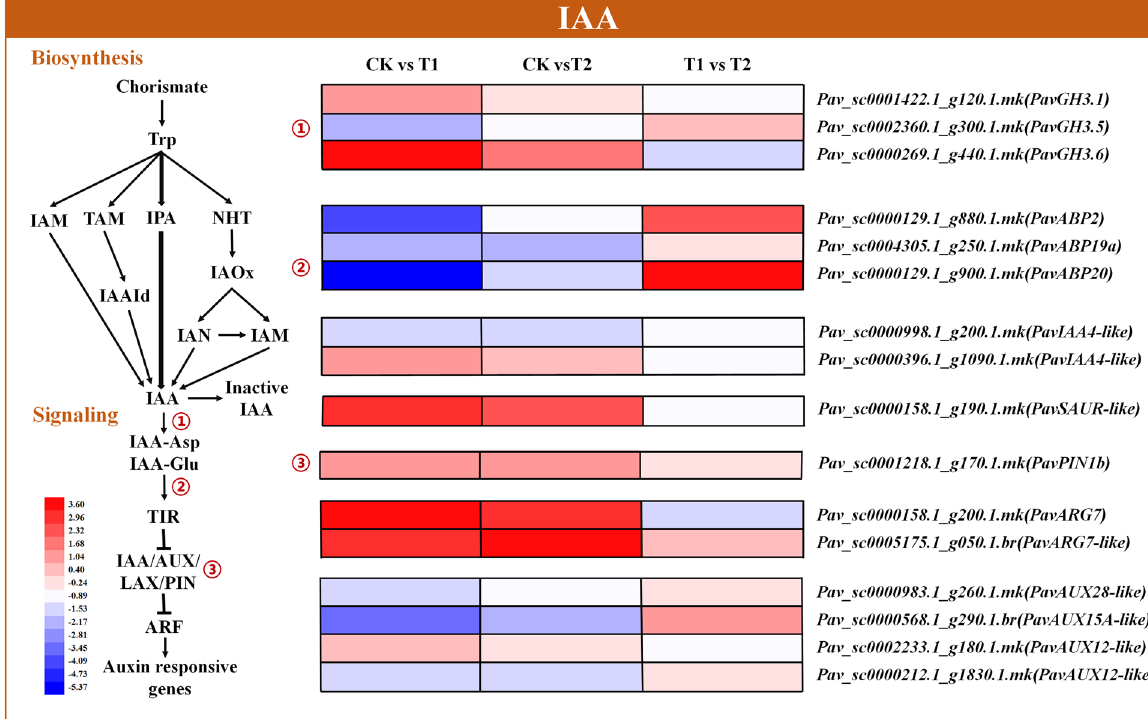
Table S11). Representative genes involved CTK synthase